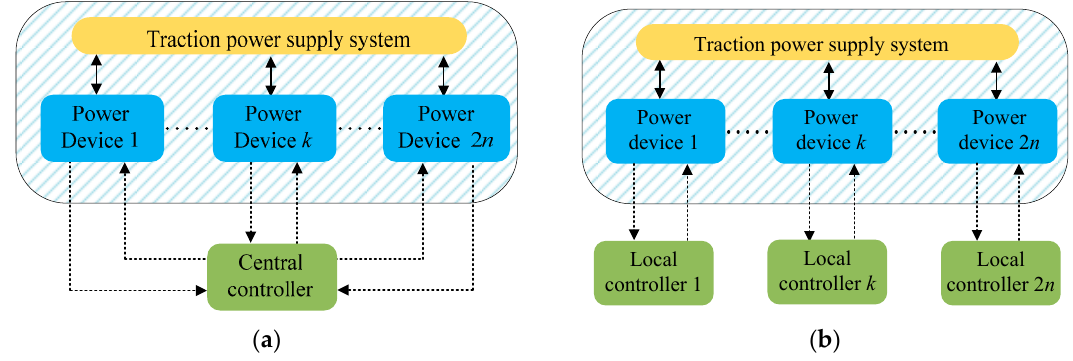
Figure 2. Control modes ( a ) centralized control; ( b ) decentralized control.